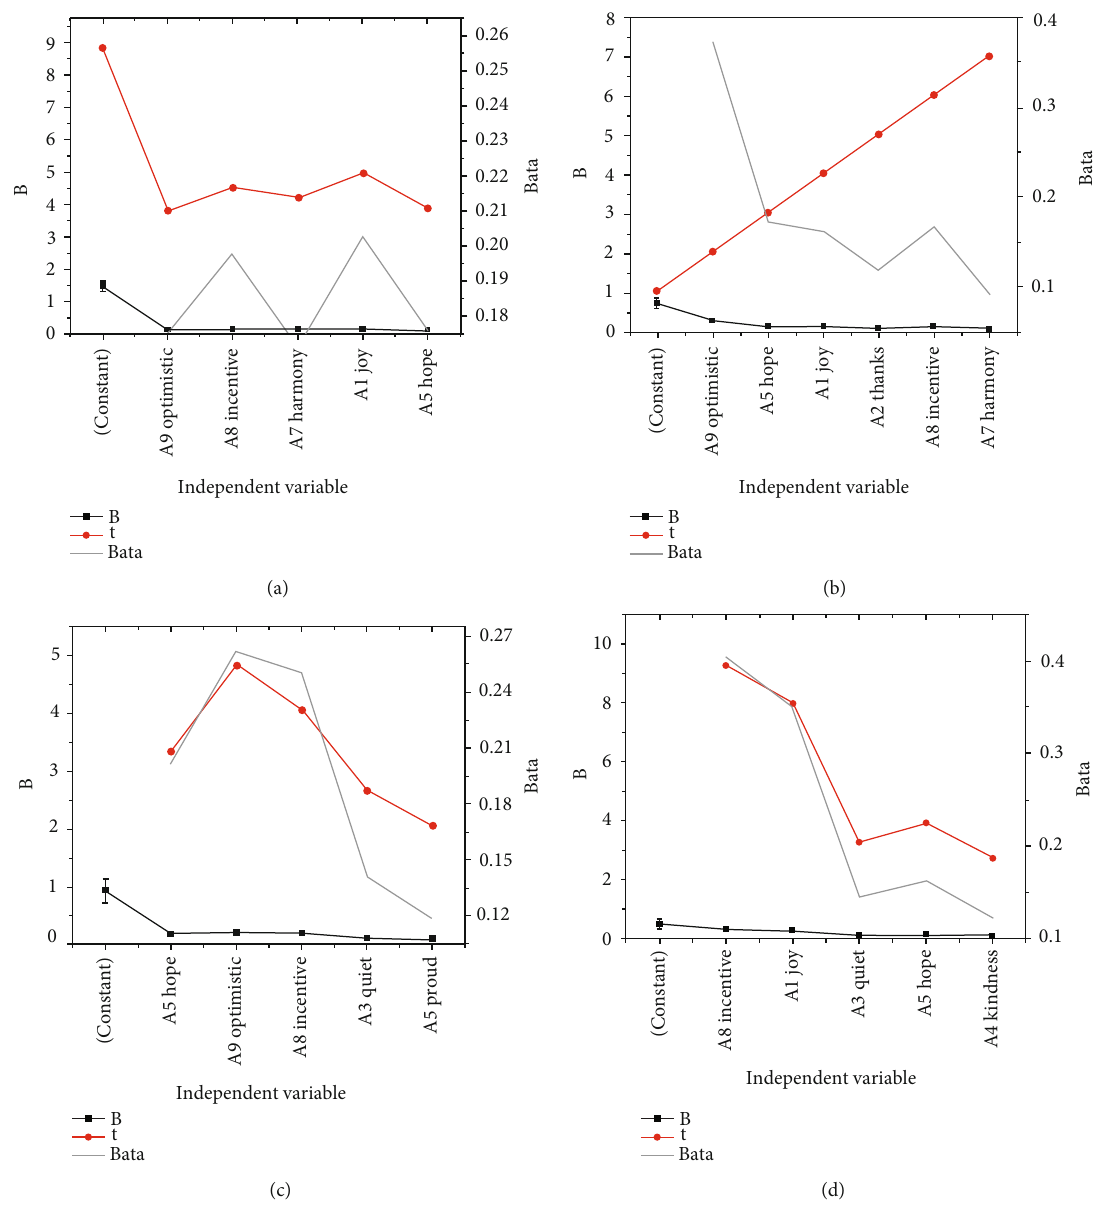
Figure 10: QS results of the enhancement e ff ect of di ff erent music styles on positive emotions around the world ((a) “ Fantasia ” ; (b) “ G oing home ” ; (c) “ I believe ” ; (d) “ Under the Bodhi Tree ” ; B is the nonstandardized coe ffi cient; t represents the emotional